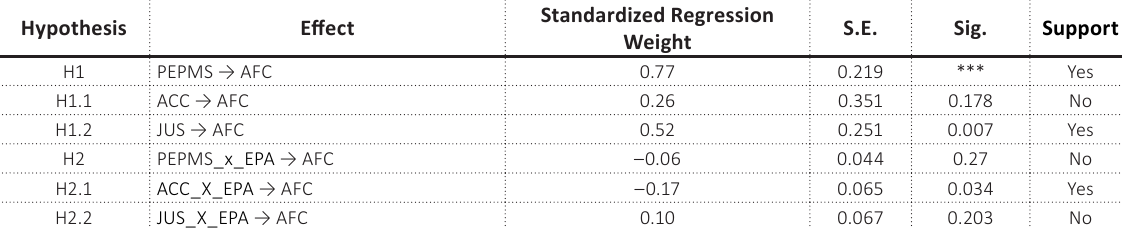
Table 5. Hypotheses testing